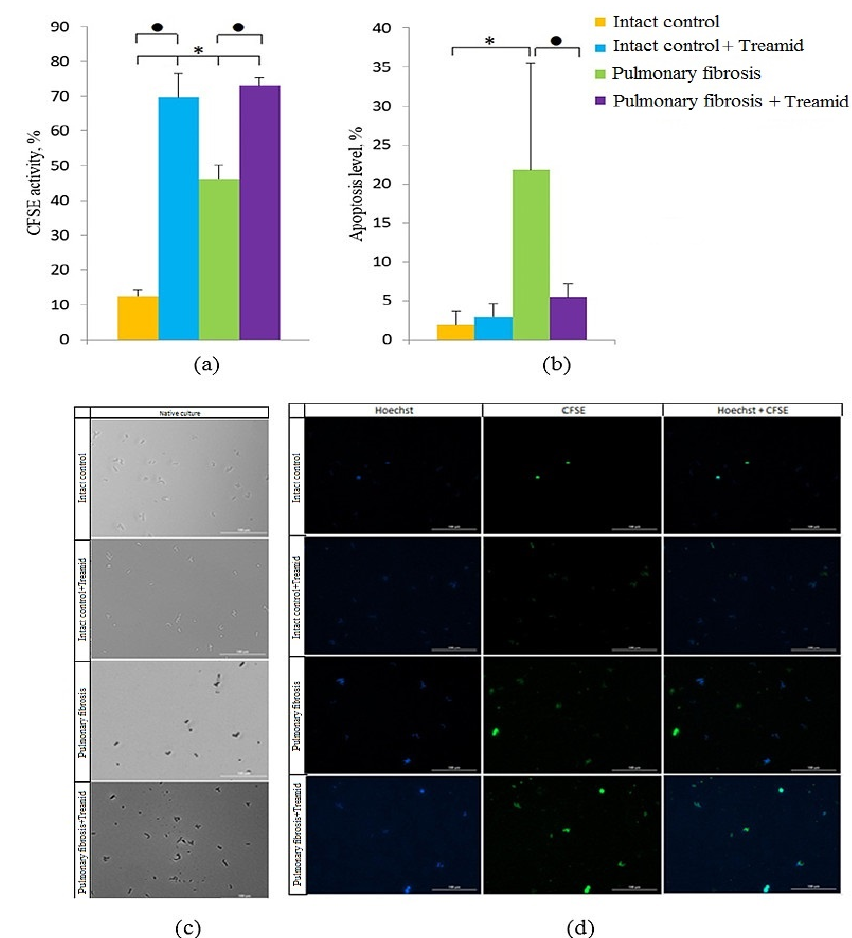
Figure 4. Effects of Treamid on culture of CD31 + endothelial cells isolated from the lungs of male